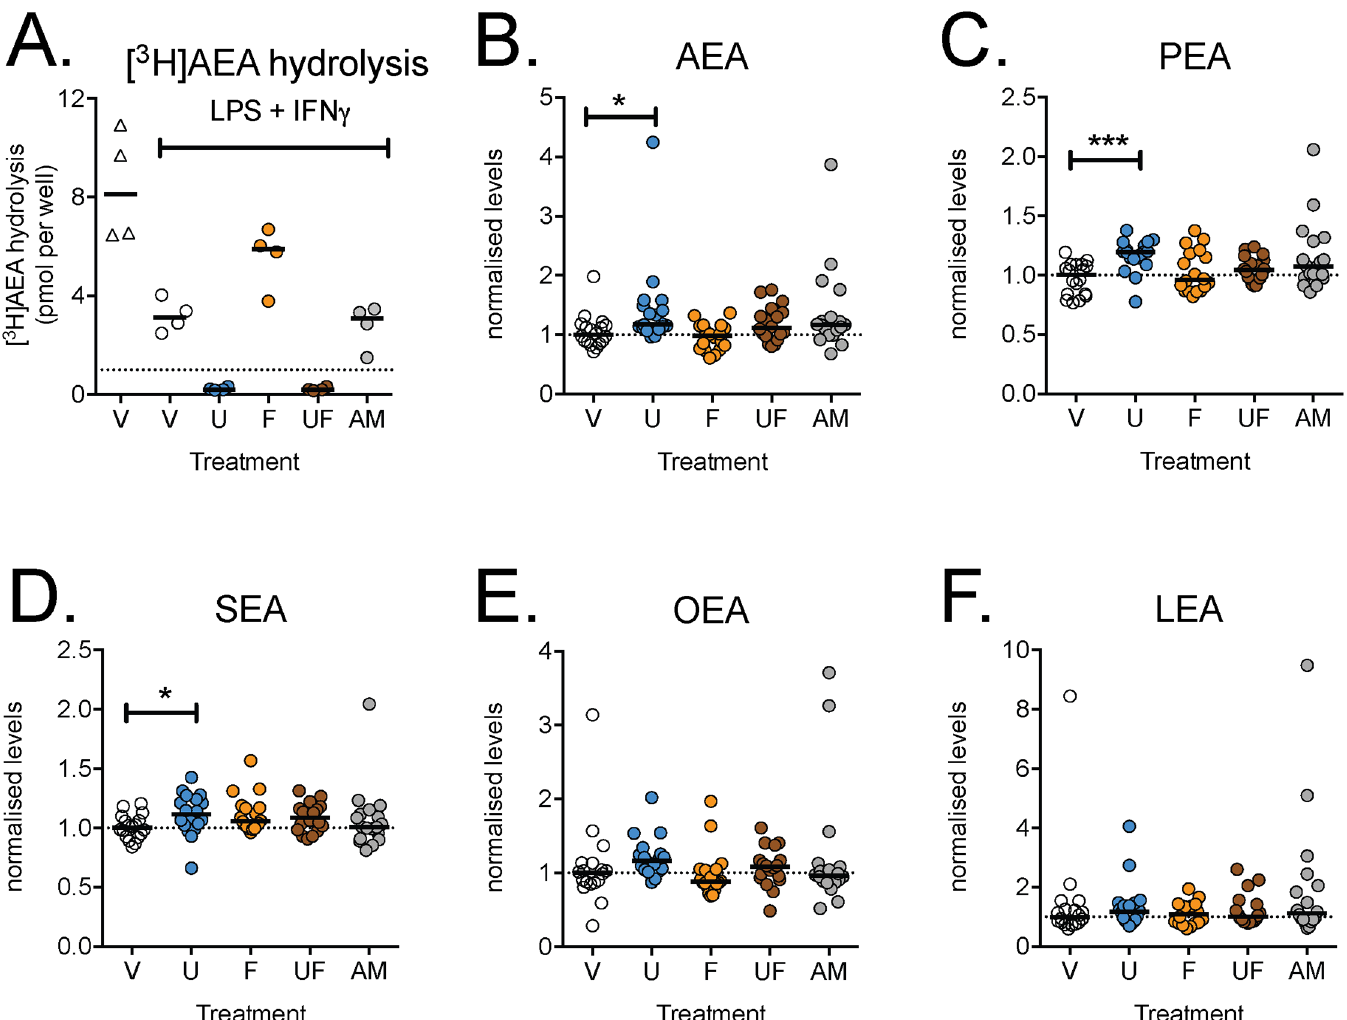
Fig 6. Effects of FAAH and/or COX inhibitors upon A. the hydrolysis of exogenously added [ 3 H]AEA and B-F the levels of AEA and related N - acylethanolamines in RAW 264.7 cells. In Panel A, 2.5 x 10 6 cells/well were seeded and cultured overnight prior to addition of either phosphate-buffered saline or LPS (0.1 μ g/mL) + INF- γ (100 U/mL) and incubation for a further 24 h. The hydrolysis of 100 μ M [ 3 H]AEA is shown for the different treatments (following 1 h of incubation. In Panels B-F, cells (2.5x10 5 per well) were added to 6 well-plates with LPS (0.1 μ g/mL well) and INF- γ (100 U/mL) and cultured at 37°C for 24 h. prior to incubation for 30 min with ionomycin (5 μ M) and either vehicle (V), URB597 (U, 1 μ M) or ( R )-Flu-AM1 (AM, 10 μ M). The median value for each lipid and batch for vehicle-treated conditions were set to unity and all other values for the batch were expressed relative to these median values. Data are shown as scatterplots (n = 18) with medians as bars. * P < 0.05, *** P < 0.001, Dunn ’ s Multiple Comparison test vs . vehicle (otherwise not significant) following significant Kruskal-Wallis